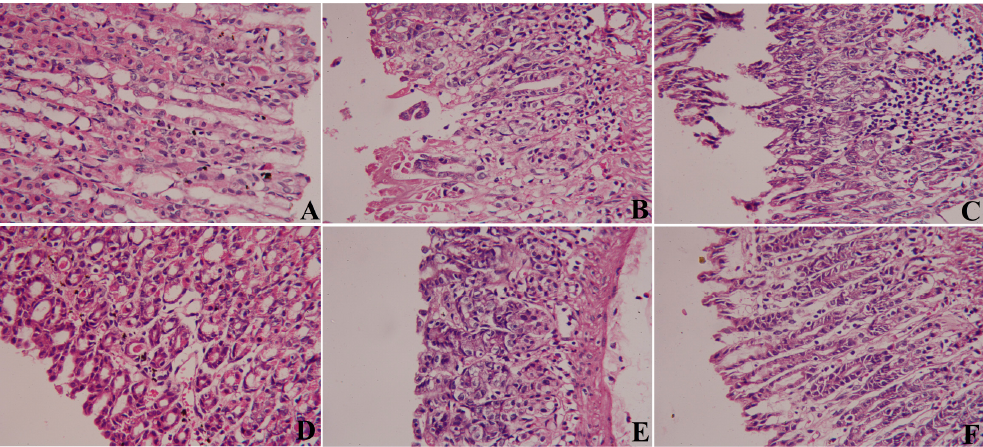
Figure 4. Hematoxylin and eosin (H&E) of stomach sections after the treatment with tested com- pounds and positive controls. ( A ) The stomach of control rats; ( B ) the stomach of rats treated with celecoxib showing normal gastric texture; ( C ) stomach of rats treated with diclofenac showed se- vere gastric damage where the gastric mucosa showed thinning, paleness, erosion and irregular arrangement; ( D ) stomach of rats treated with 6b showed normal gastric texture; ( E ) stomach of rats treated with 6e showed severe pathogenic changes; ( F ) stomach of rats treated with 6j showed normal gastric texture.